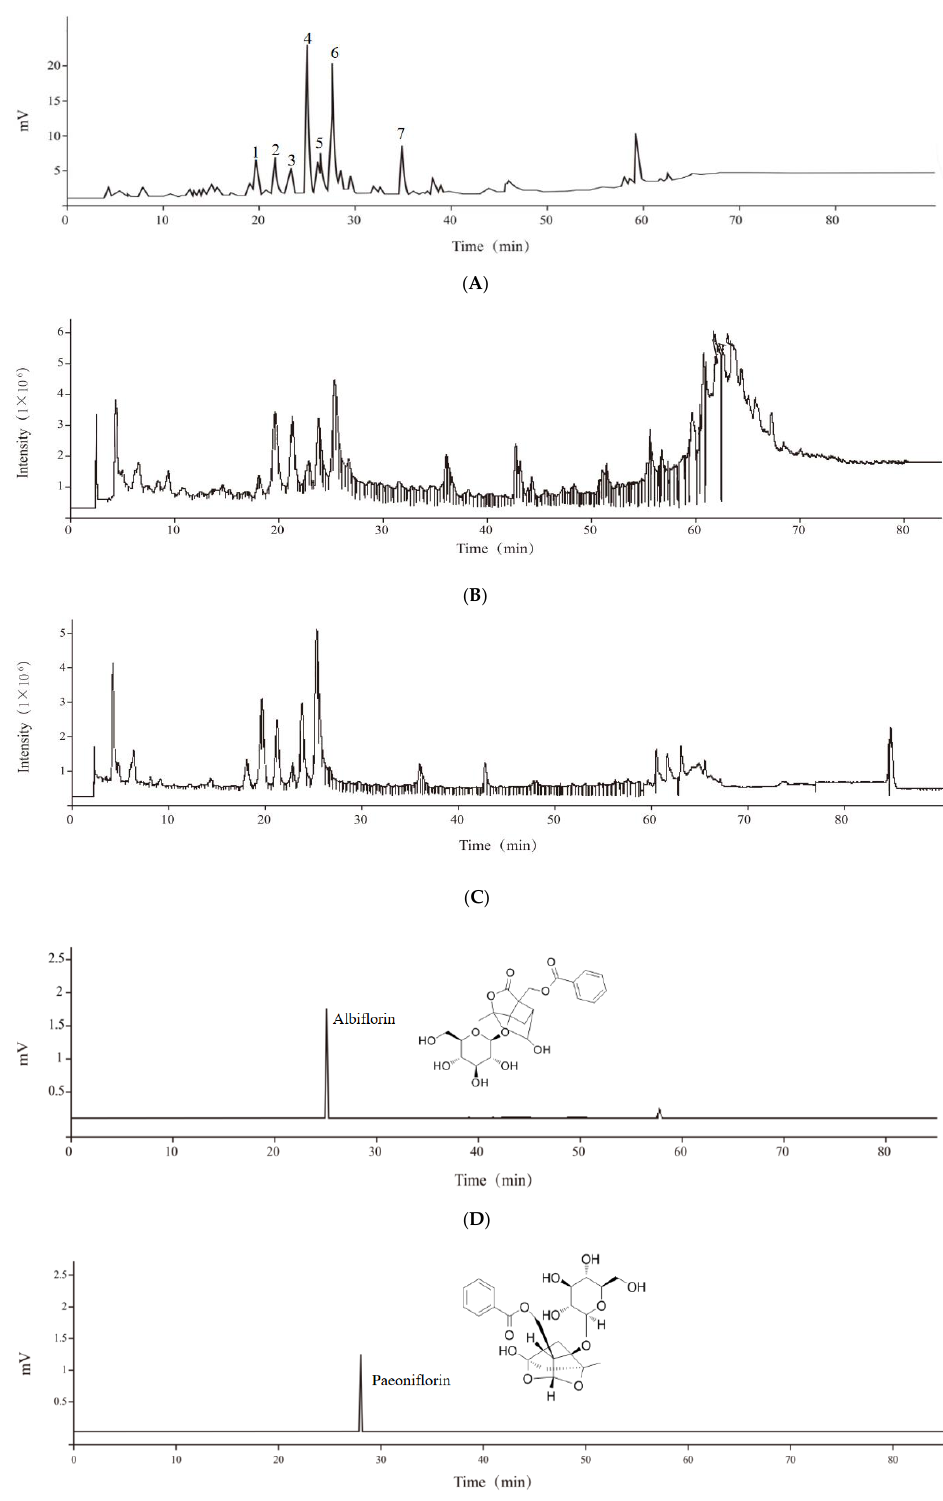
Figure 6. Analysis of the monoterpene glycoside compounds in the purified extract from P. suffruticosa. HPLC chromatograms (280 nm) of the monoterpene glycoside extract from P. suffruticosa ( A ) where: 1, unknown; 2, oxypaeoniflorin; 3, isomaltose paeoniflorin; 4, albiflorin; 5, 6 ′ -O- β -D-gluco- side albiflorin; 6, paeoniflorin; 7, paeonoside i. Total ion chromatograms (TICs) in positive ( B ), total ion chromatograms (TICs) in negative ( C ). HPLC chromatograms (280 nm) of albiflorin ( D ) and peoniflorin ( E ).